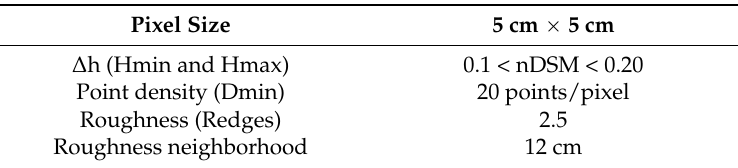
Figure 12. Point cloud measured by a RIEGL sensor used as Test Site 2 ( a ). Ortho-image of the studied area overlapped by segmented curbs ( b ). Table 3. Algorithm settings used at Test Site